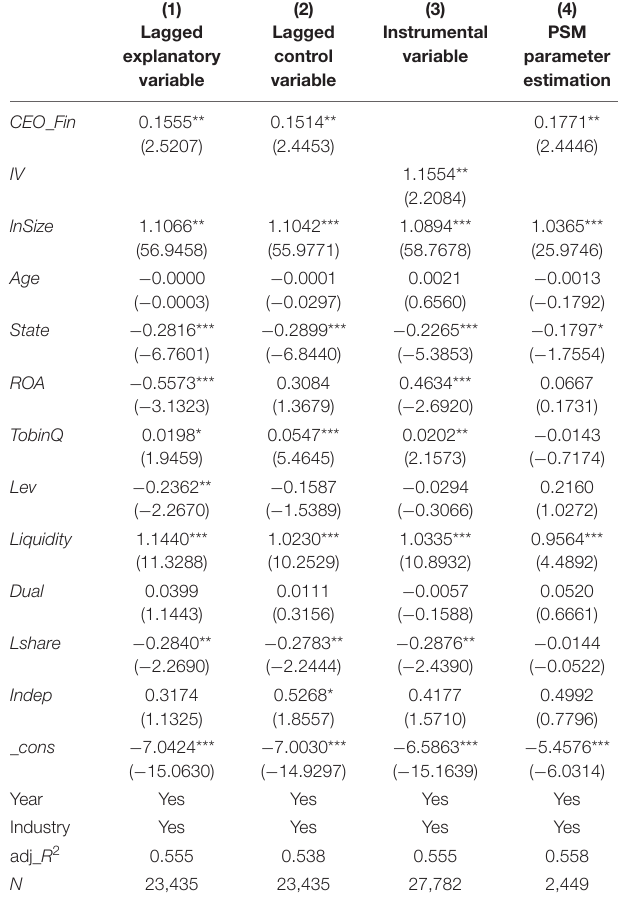
TABLE 5 | Lagged variables, instrumental variables, and PSM parameter